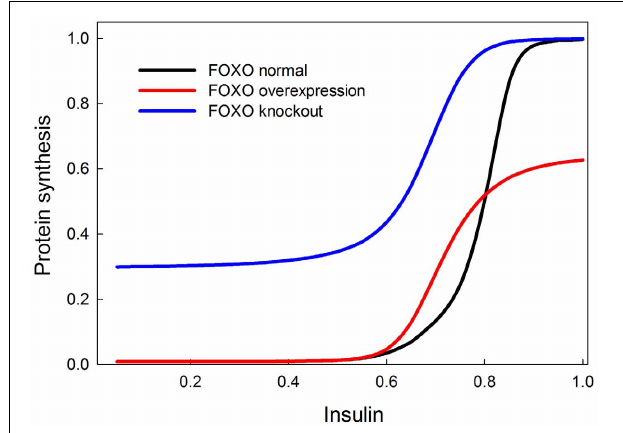
FIGURE 9 | Effect of overexpression and knockout of FOXO on insulin-stimulated protein synthesis. FOXO knockout increases protein synthesis especially at low levels of insulin stimulation. On the other hand, FOXO overexpression primarily affects protein synthesis when insulin signaling is high. These two observations can be explained by the fact that FOXO inhibits TOR and this inhibition is inhibited by PKB when insulin is high. At low insulin levels, FOXO should inhibit TOR and protein synthesis, and hence the knockout relieves this inhibition. At high insulin levels, FOXO should be inhibited by PKB and therefore not have an inhibitory effect on protein synthesis, but FOXO overexpression prevents PKB from entirely relieving the constitutive inhibition of protein synthesis by FOXO.